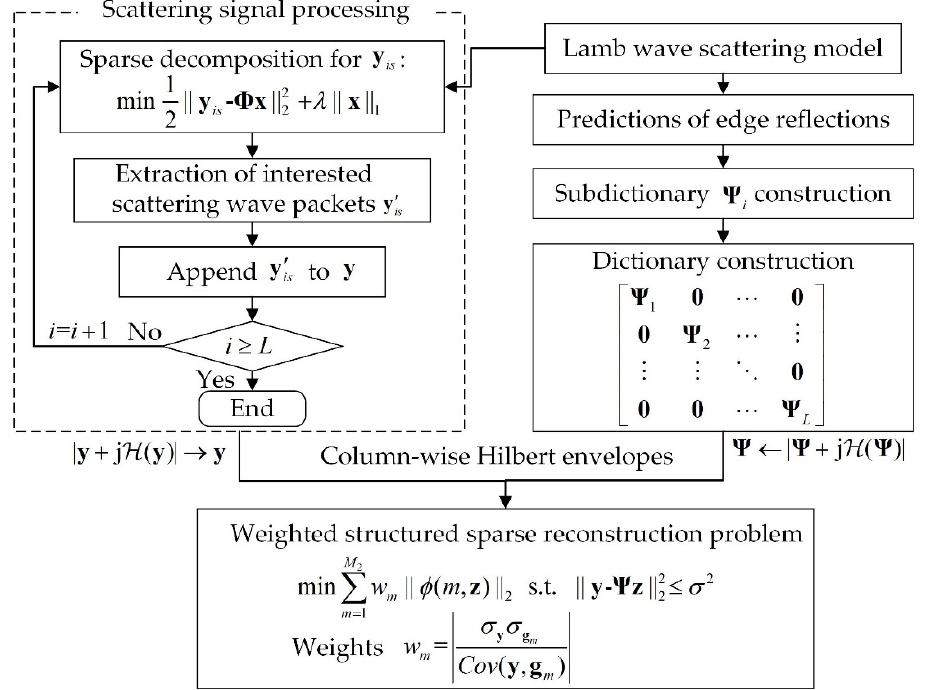
Figure 2. Schematic of the weighted structured sparse reconstruction-based Lamb wave imaging method.